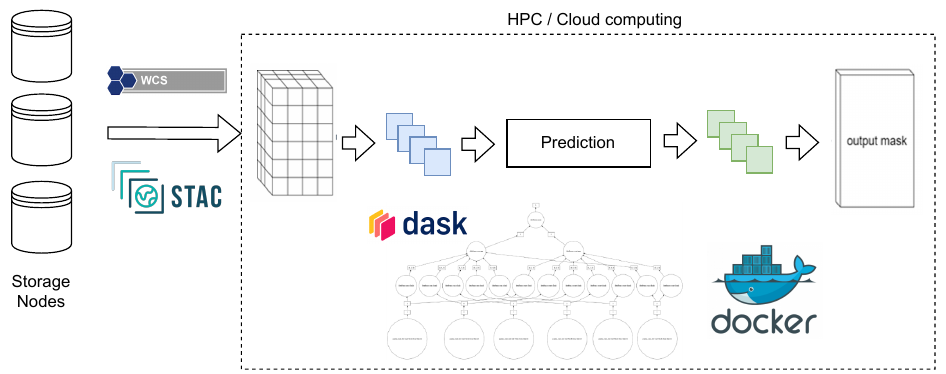
Figure 3. Inference Pipeline scheme. On the left, the process of the Sentinel-2 satellite imagery retrieval. On the right, the execution of the prediction. As detailed in Section 3.3, we choose Docker to set up the image for the inference. Dask makes the solution scalable by parallelising the